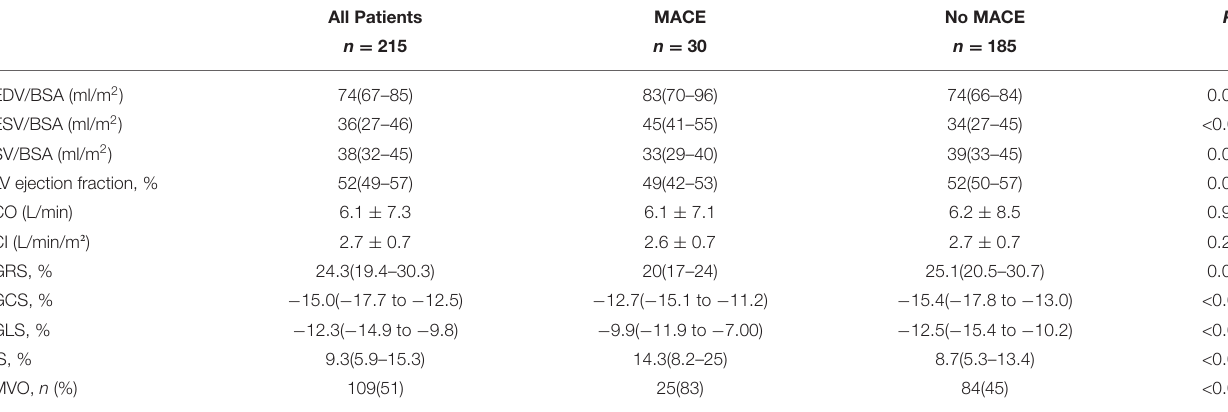
TABLE 2 | CMR parameters of the study population.